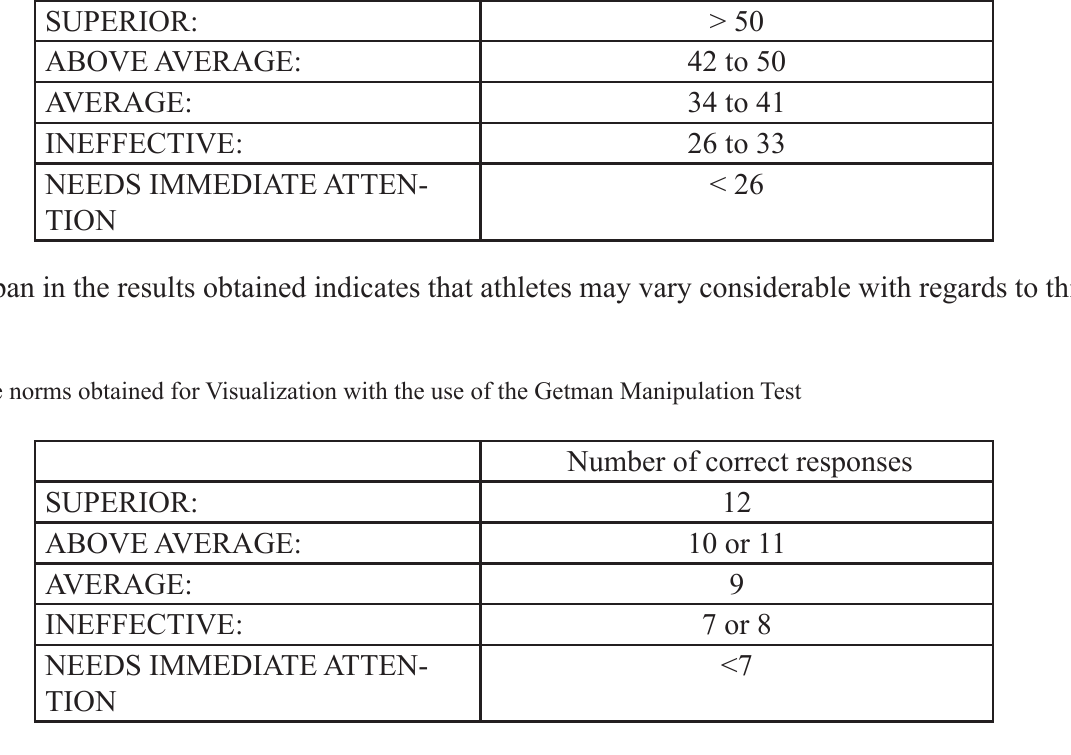
Table 13: The norms obtained for Visual Concentration with the use of the Acuvision 1000 Number of lights correctly detected